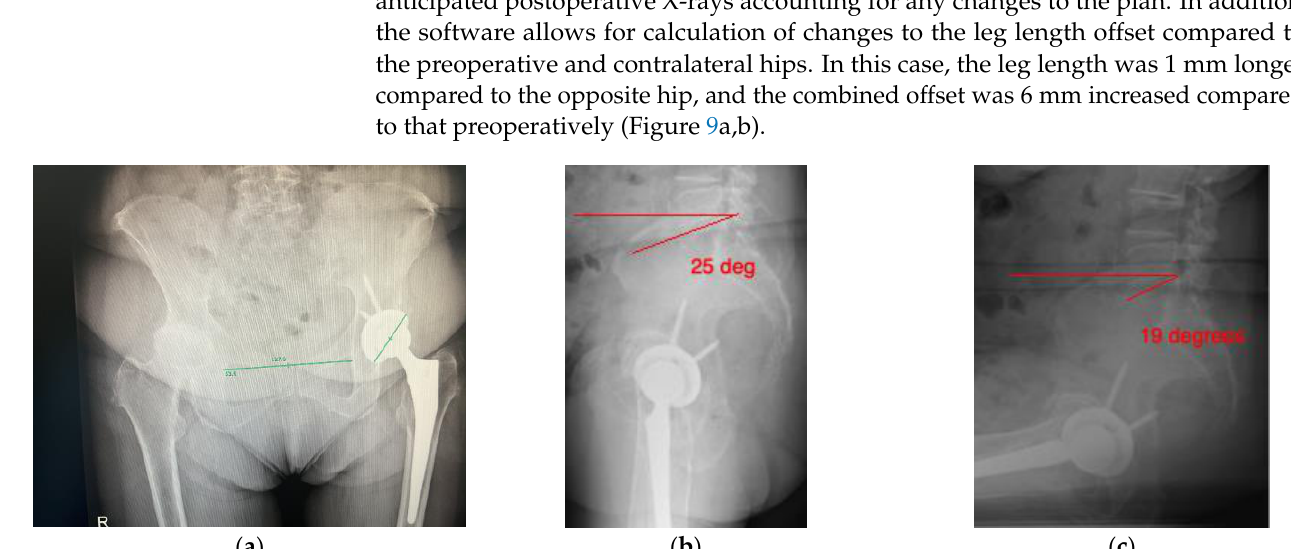
Figure 6. ( a ) AP pelvis radiograph; ( b ) standing lateral lumbar radiograph showing sacral slope of 25 degrees; ( c ) sitting lumbar radiograph showing sacral slope of 19 degrees.